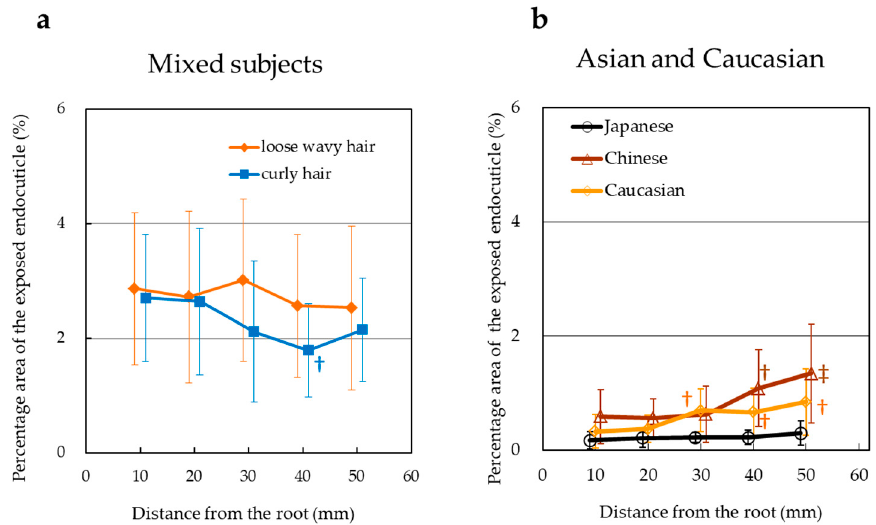
Figure 5. ( a ) The levels of “exposed endocuticle” damage of the mixed-race subjects are plotted according to hair shape. There were no statistically significant differences between loose wavy and curly hairs ( p > 0.05). ( b ) The levels of “exposed endocuticle” damage of the monoracial subjects. The † and ‡ indicate statistically significant di ff erences between the marked data and the data at 10 mm ( p < 0.05 and p < 0.01, respectively).